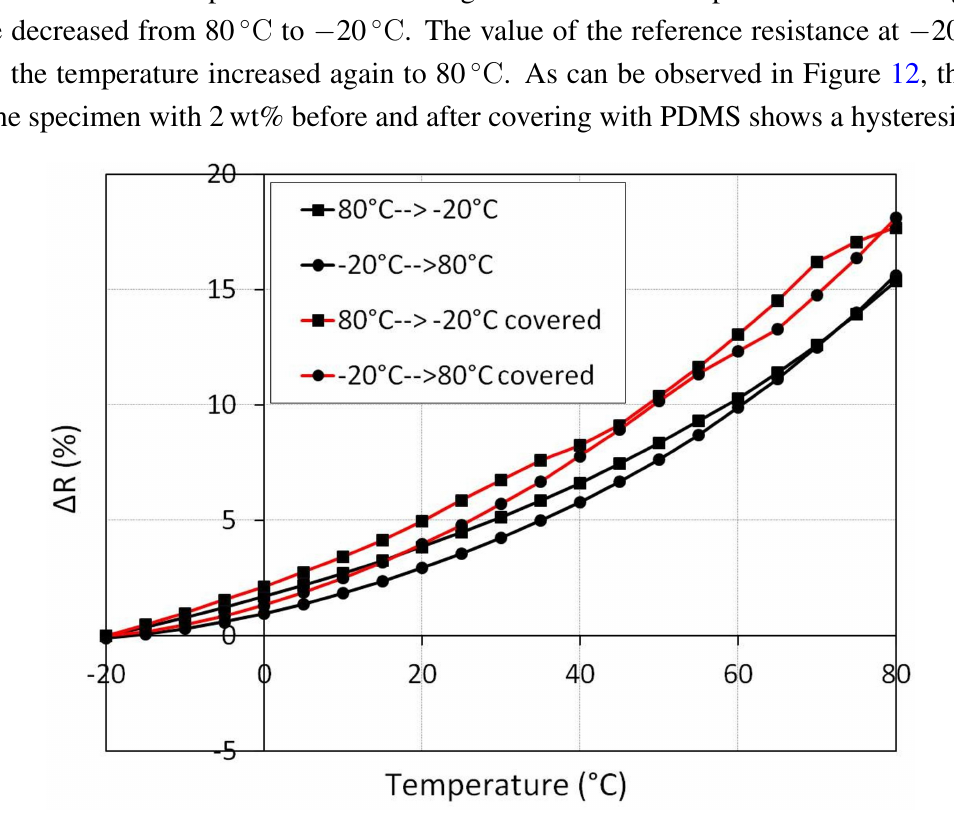
Figure 12. Resistance hysteresis in one temperature cycle (sample with 2 wt%). Black lines indicate the native MWCNT specimen; red lines indicate the PDMS-covered MWCNT